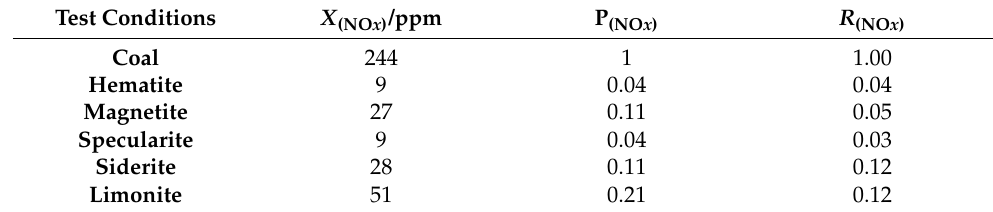
Figure 5. Emission characteristics of flue gas components during oxidative roasting of iron-bearing pure minerals. ( a ) NO x concentration, ( b ) O 2 concentration, ( c ) CO 2 concentration, ( d ) CO concentration. Table 4. List of X (NO x ) , P (NO x ) and R (NO x ) values during oxidative roasting of iron-bearing pure minerals.